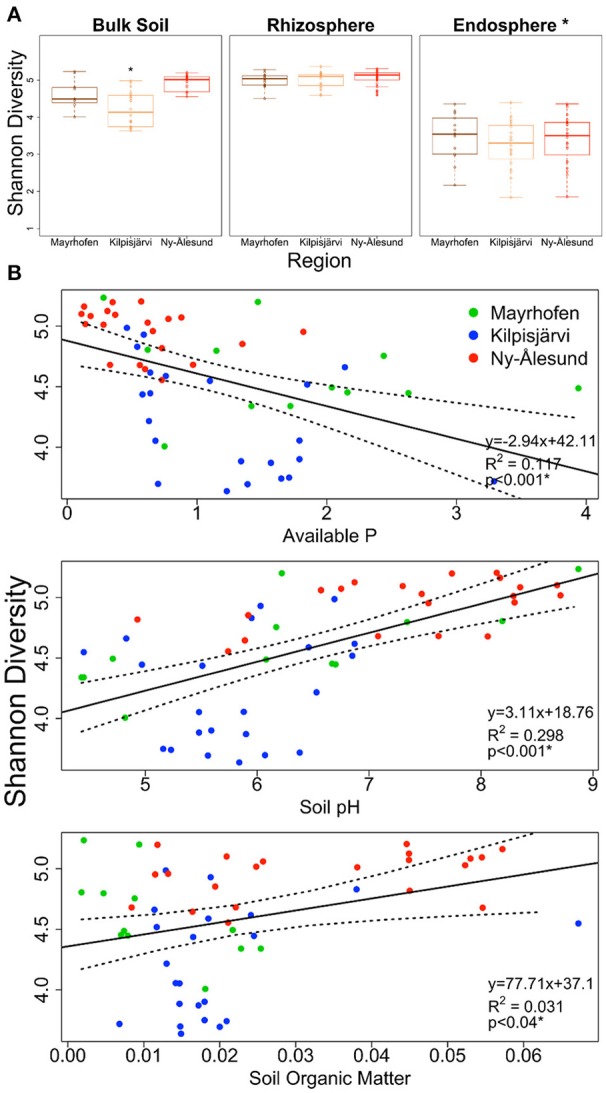
Estimated Shannon diversity (A) in bulk soil, rhizosphere soil and endophytic bacterial communities from three climatic regions Mayrhofen, Kilpisjärvi and Ny-Ålesund. (B) Scatter plots of bulk soil communities explaining the correlation (Pearson correlation) of Shannon diversity with soil-physico chemical properties from three climatic regions.